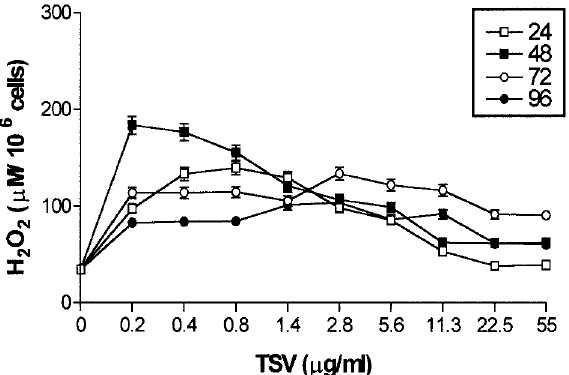
FIG. 4. Macrophage activation. Peritoneal macrophages were obtained and stimulated in vitro as described in Fig. 1. The activation of the cultured peritoneal macrophages was determined by measuring the oxygen intermediate metabo- lites (H 2 O 2 ). Each point represents the mean ± standard deviation value of samples from five experiments in different groups of five